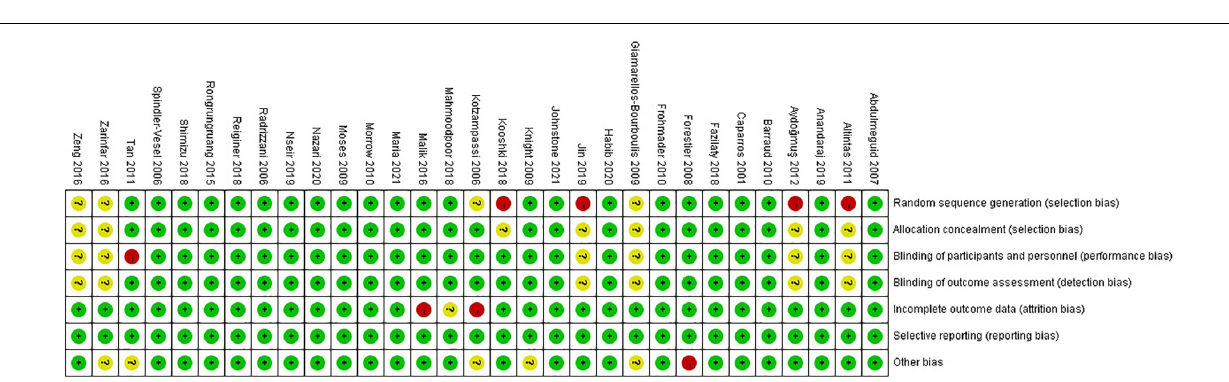
FIGURE 2 | Risk of bias assessment graph for included studies. Review authors’ judgments (low, unclear, and high) for each risk of bias item shown as percentages across all included studies.